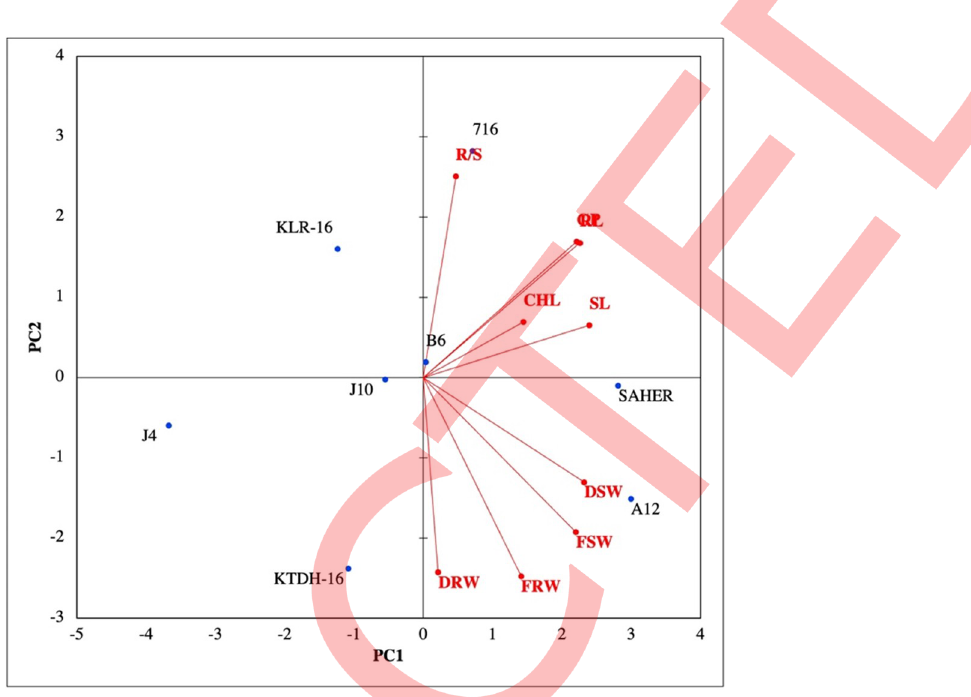
Fig 2. Biplot of the first two principal components of principal component analysis executed on percentage decrease in seed germination and growth traits of wheat genotypes included in the study. Here, GP = seed germination percentage, RL = root length, SL = shoot length, RFW = root fresh weight, RDW = root dry weight, SFW = shoot fresh weight, SDW = shoot dry weight, R/S = root:shoot ratio, Chl = chlorophyll index.